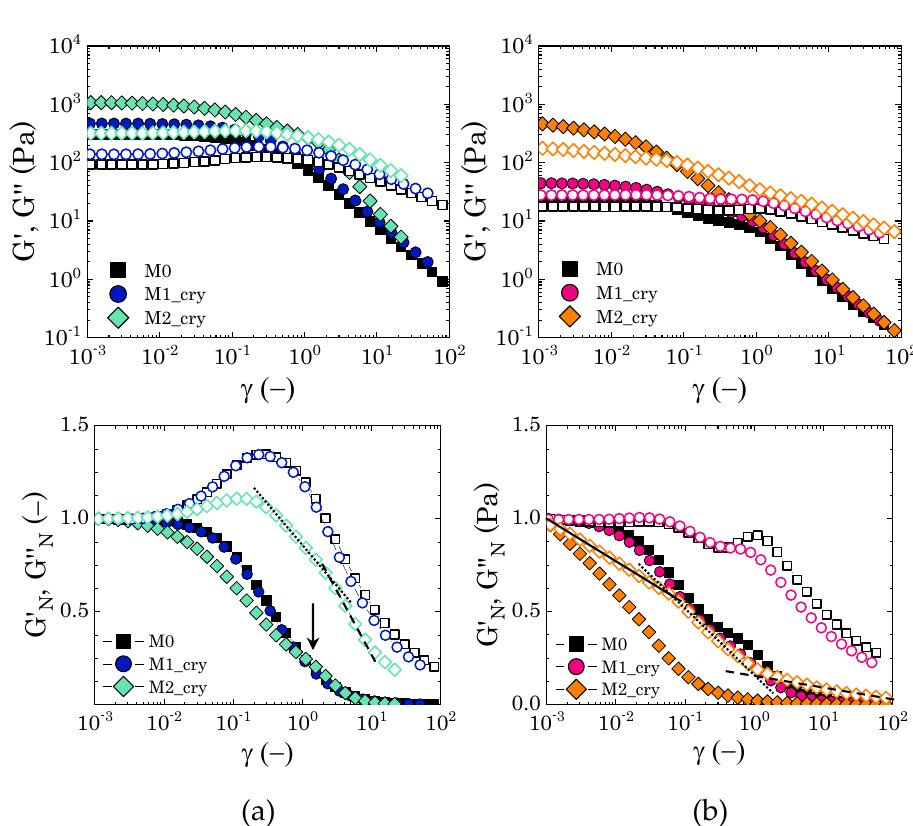
Figure 7. ( a ) Strain amplitude dependence of the storage (closed) and loss (open) moduli (upper panel) and of the corresponding normalized quantities (bottom panel) at ω = 1 rad/s for a Carbopol mass fraction of 2% wt in the absence of mannitol (M0) and for the two mannitol concentrations considered, in the presence of crystals. The black arrow points to the local maximum of G (cid:48) . ( b ) The N strain amplitude dependence of the storage (closed) and loss (open) moduli (upper panel) and of the corresponding normalized quantities (bottom panel) at ω = 1 rad/s for a Carbopol mass fraction of 0.9% wt in the absence of mannitol (M0) and for the two mannitol concentrations considered, in the presence of crystals. The black solid, dotted, and dashed lines are guides for the eye to indicate the two different decays, followed by G (cid:48)(cid:48) N